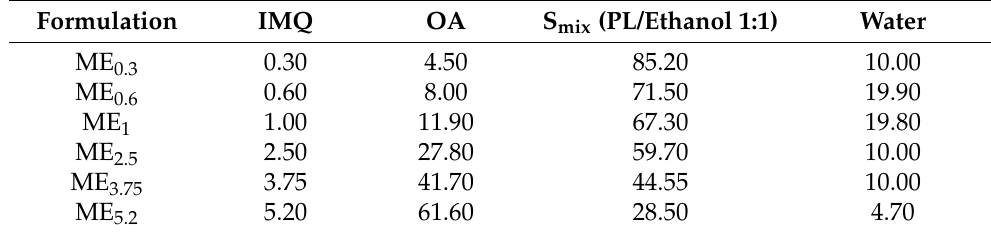
Table 1. Composition (weight%) of the studied MEs.